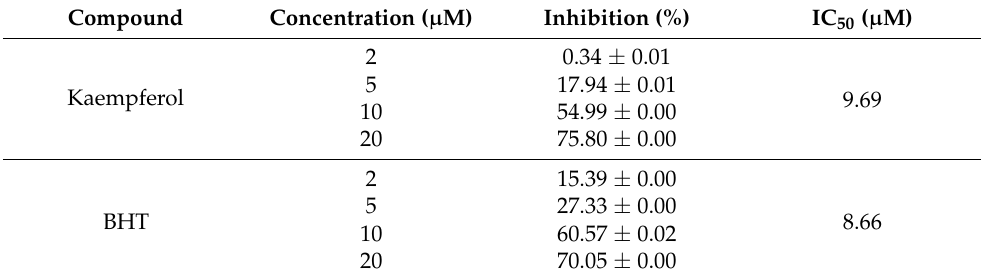
Table 1. Antioxidative activities of kaempferol against the FeSO 4 /H 2 O 2 -induced lipid peroxidation.